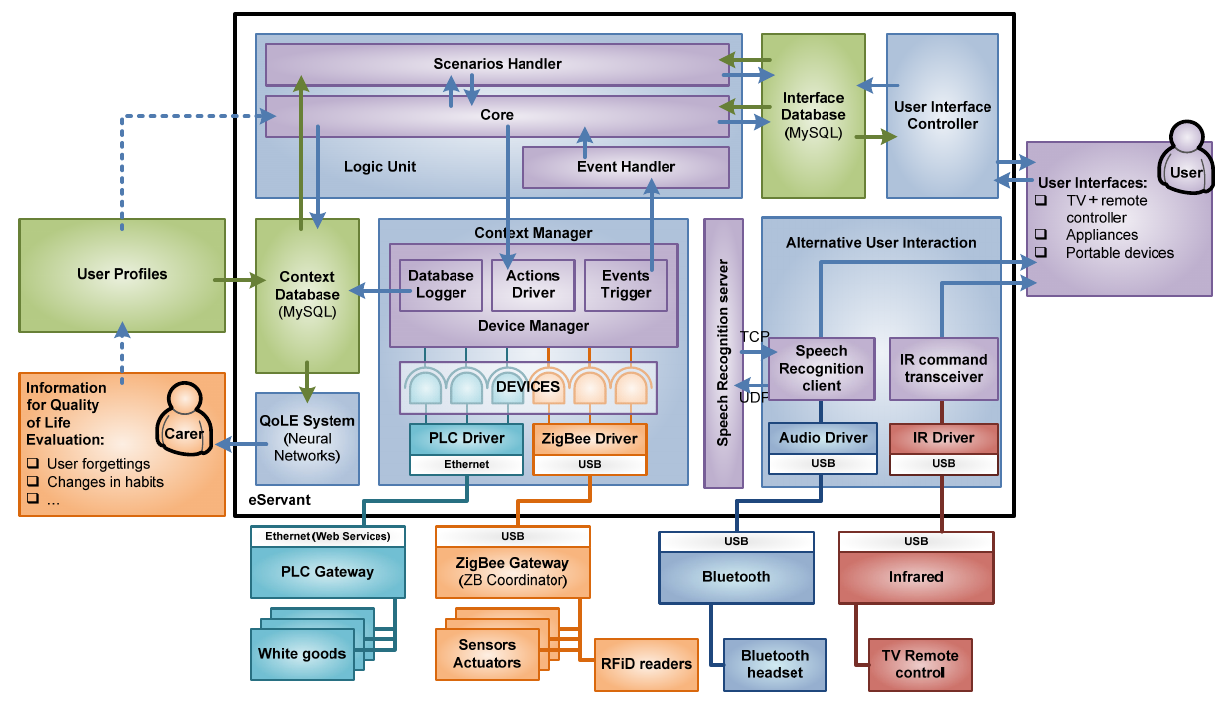
Figure 3. Software architecture of the